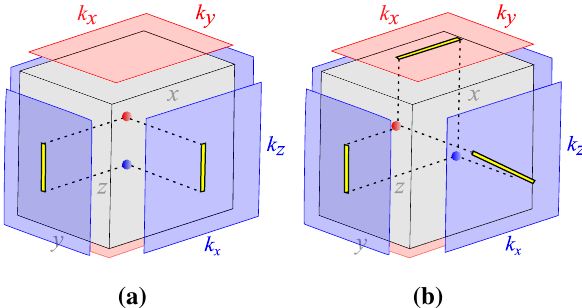
k z and k y k z (four light blue planes). ( b ) − − k y (two light red planes). Note that, the −